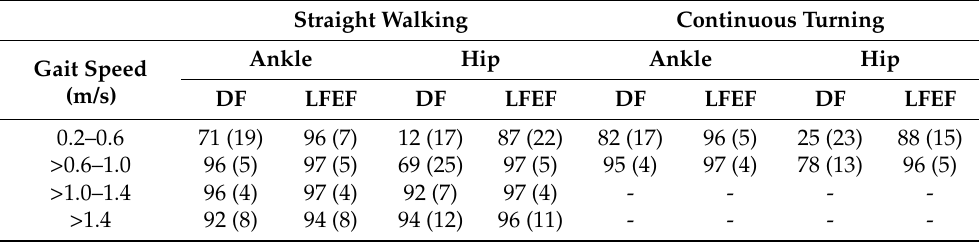
Table 1. Mean percentage agreement (standard deviation) between SW activity monitor and ankle and hip worn AG using the DF and LFEF for different gait speeds during straight walking and walking with continuous turns.